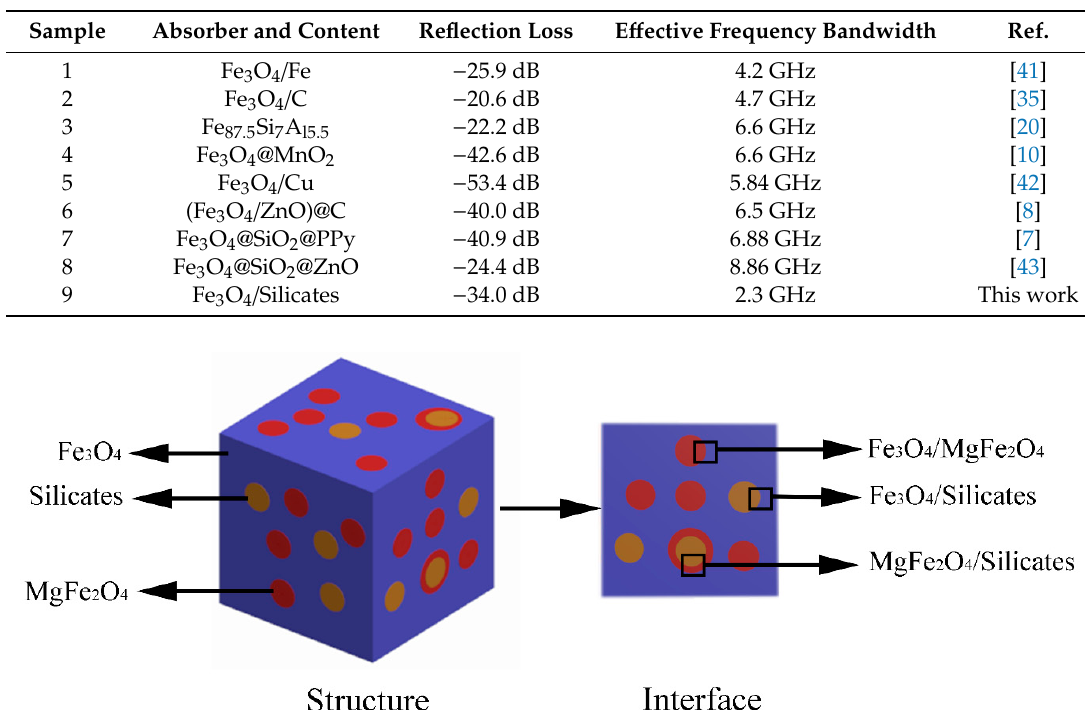
Table 5. Microwave absorption properties of MPs and other related composites in the frequency range of 2–18 GHz.